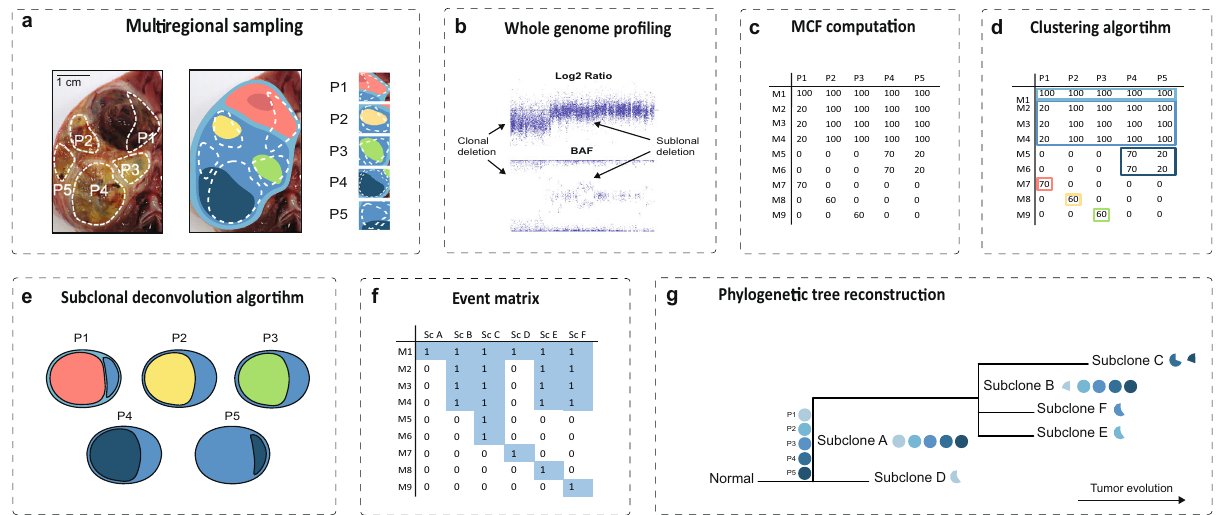
Fig. 1 Overview of the methodological outline. a An example of multiregional sampling to obtain biopsies P1-P5 from a Wilms tumor. The tumor is composed of several subclones with distinct genomic pro fi les, exempli fi ed by the schematic genomic landscape in the rightmost panel where each color uni fi es cells with identical sets of genetic alterations. The photograph is adapted from a previous publication 14 and the colors do not represent true sets of genetic alterations. b Acquisition of genomic tumor data for each sample, exempli fi ed by copy number analysis by SNP-array. c The whole genome pro fi ling data can be used to compute the mutated clone fraction (MCF) illustrating the proportion of cells in each biopsy harboring a certain genetic alteration (M1- 9 in the left column). d A clustering algorithm is employed to identify genetic alterations that seem to follow each other in size across samples. e A subclonal deconvolution algorithm determines the temporal order of these clusters by considering the information obtained throughout all samples while minimizing the occurrence of parallel evolution and back mutations. f The proposed solution for the temporal order of subclones (Sc) is integrated into an event matrix. g This event matrix can be used to generate phylogenetic trees with either the maximum likelihood or the parsimony method. At the stem, all available biopsies for the patient are visualized as fi lled circles with the biopsy name (P1 – P5). At the branches of the tree the subclones can be seen along with pie charts illustrating in which biopsies, and in what fraction of the tumor cells they